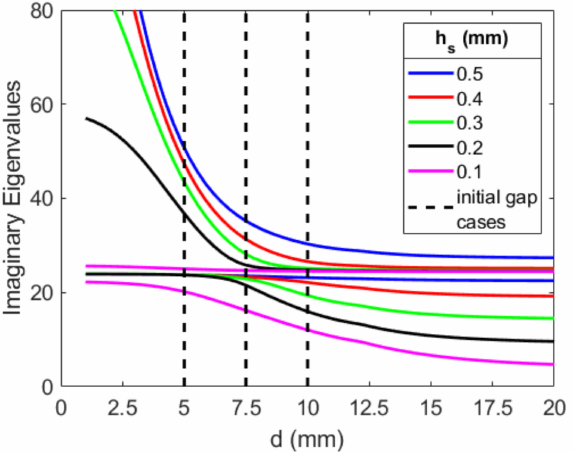
Figure A4. The effects of varying substrate thicknesses with a tip mass of 0.04 kg and an initial gap of 5 mm on the amplitude of the ( a ) primary structure and ( b ) absorber, as well as a comparison with configurations with no magnets ( c , d ).